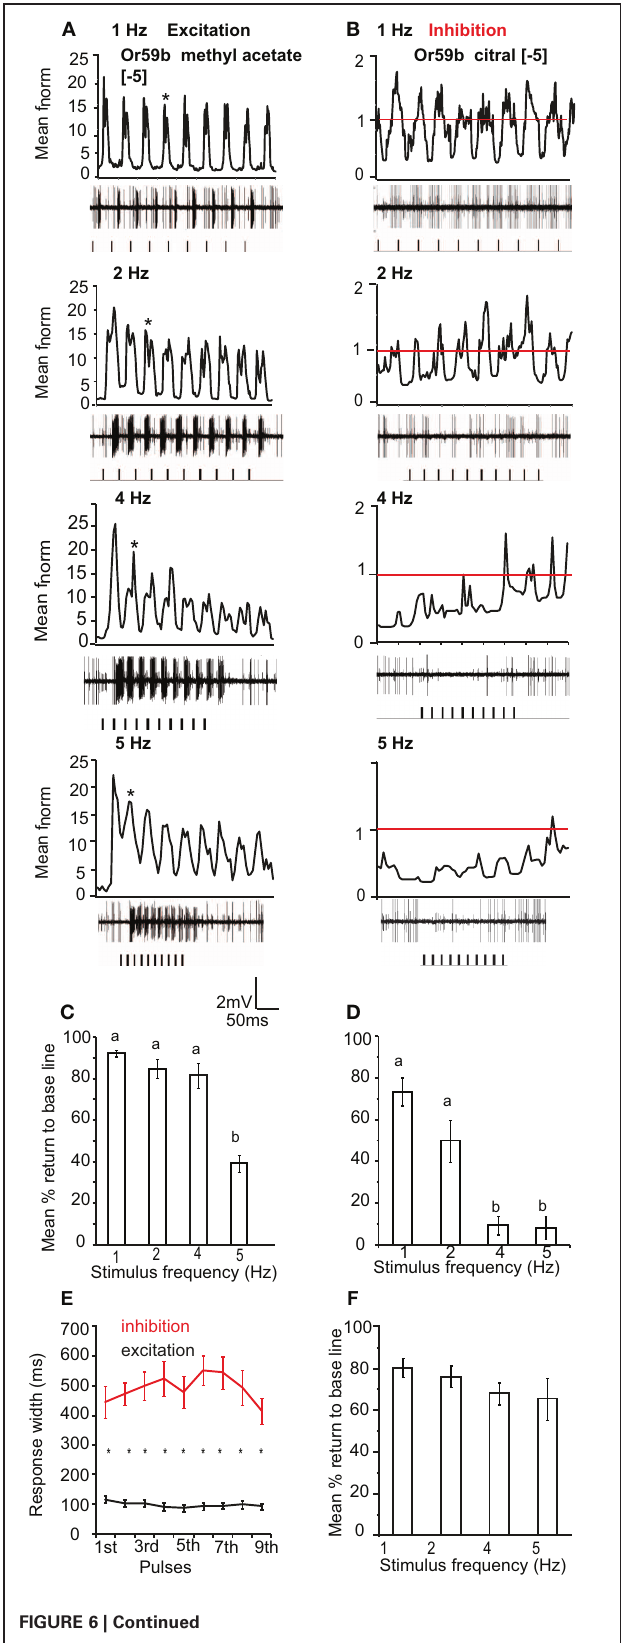
FIGURE 6 | OR-expressing OSN response polarity and pulse resolution. (A) Mean normalized PSTH response of Or59b-expressing OSNs to repeated pulses of log [ − 5] v/v methyl acetate at listed frequencies. Traces below each panel show sample 50ms recordings. Square pulses indicate stimulus presentation. (B) Mean normalized PSTH response of Or59b-expressing OSNs to repeated pulses of log [ − 5] v/v citral (an inhibitory odor) at listed frequencies as in frequency. (C) Mean percent return to base line across all pulses for Or59b-OSN response to methyl acetate, error bars indicate SEM (ANOVA, P < 0 . 05, followed by Tukey post-hoc test, n = 9–13) and (D) as in citral (ANOVA, P < 0 . 05, followed by Tukey post-hoc test, n = 13–15). (E) Mean response width of Or59b-expressing OSNs for excitation and inhibition. (F) Mean percent return to base line in response to a pulsed binary mixture of methyl acetate and citral, error bars indicate SEM, ( P > 0 . 05 ANOVA, n =